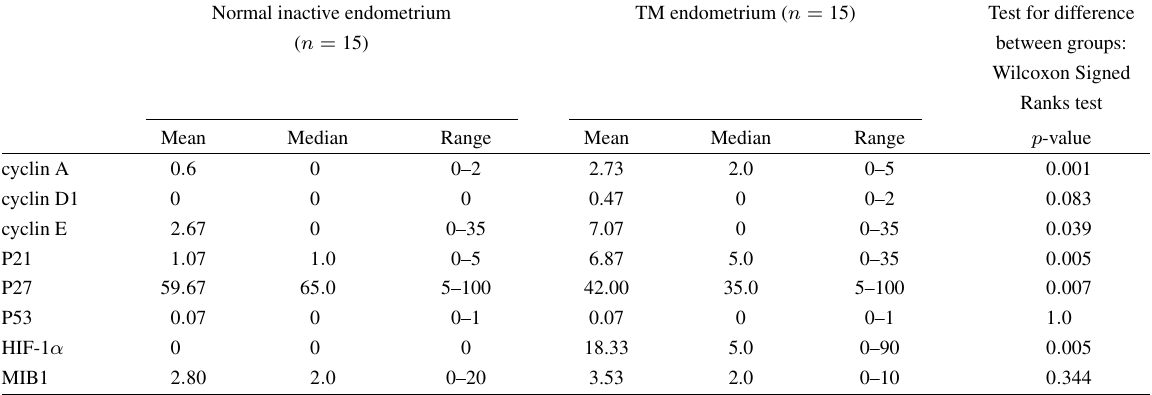
Expression of cell cycle proteins (% of positive cells) in normal inactive endometrium and tubal metaplasia (TM) of the